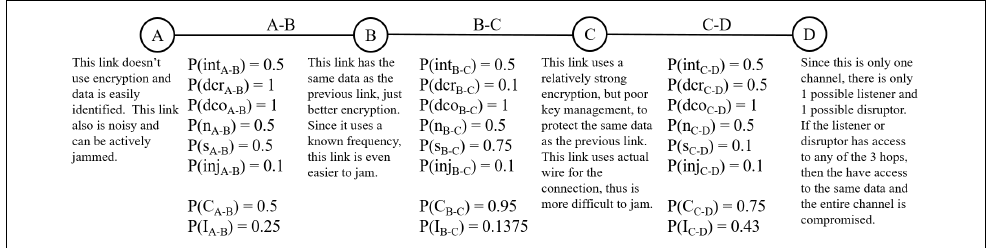
Figure 4. A Single-Channel, Three-Hop Network and QoSS Characteristics.